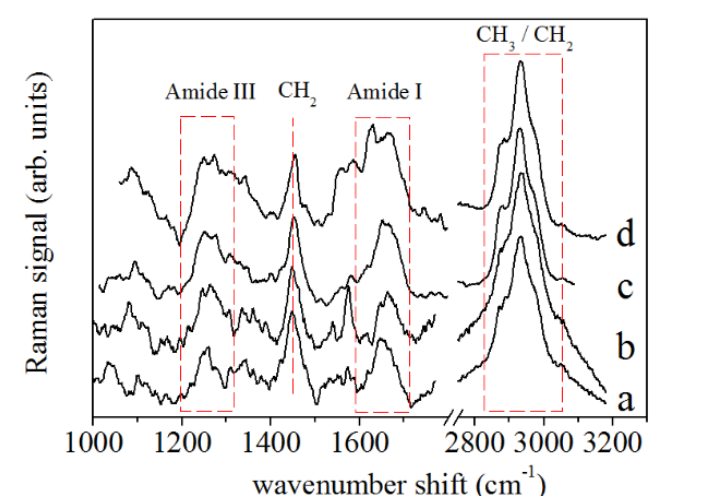
Figure 3. Raman spectra of PDL samples for ( a ) untreated case (control), ( b ) after 2 days, ( c ) 7, and ( d ) 14 days of OTM. Main Raman bands due to protein and CH 2 /CH 3 contributions are